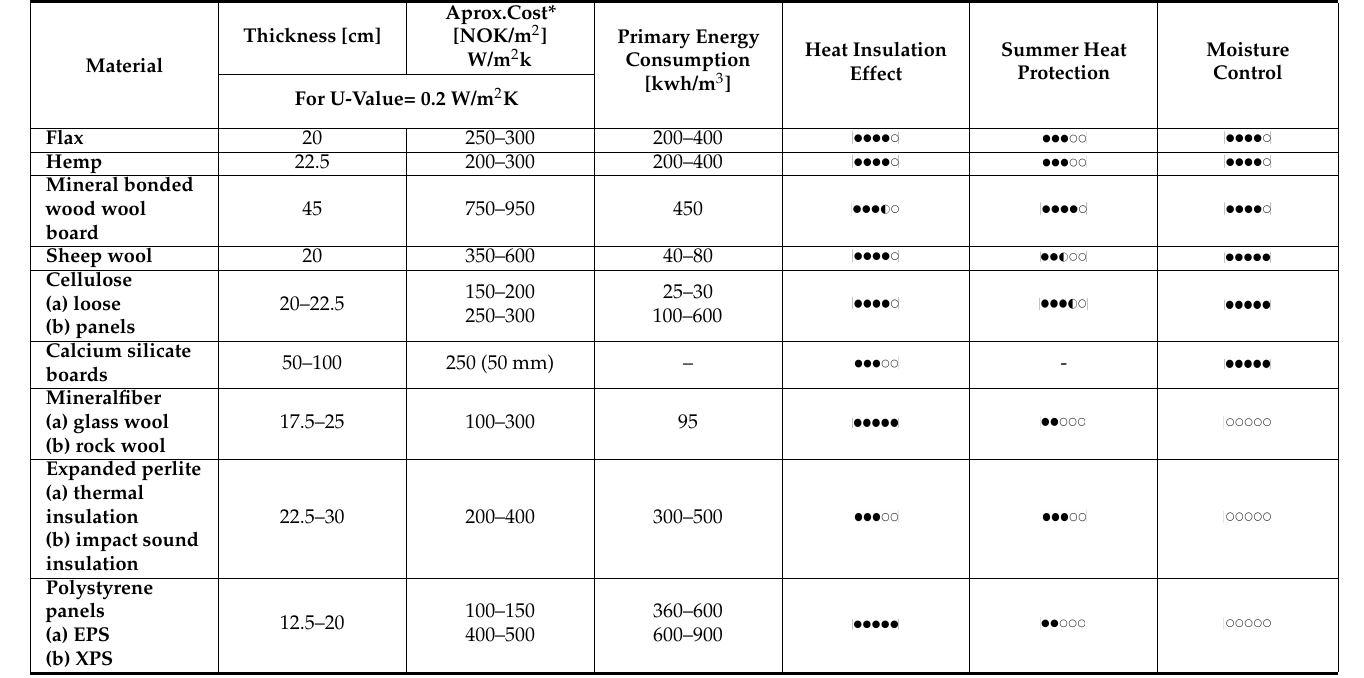
Table 4. Insulation materials and their properties (Beck,